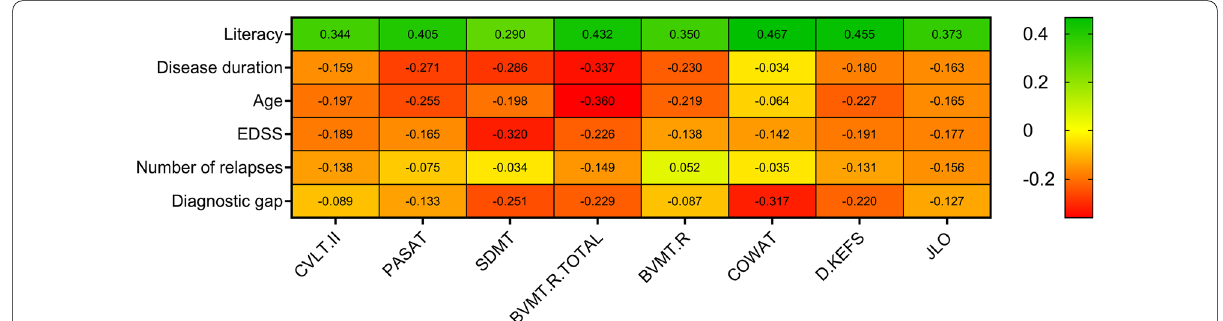
Fig. 3 The correlations between demographic characteristics and cognitive scores. The number inside each cell is “ r ” for Spearman’s